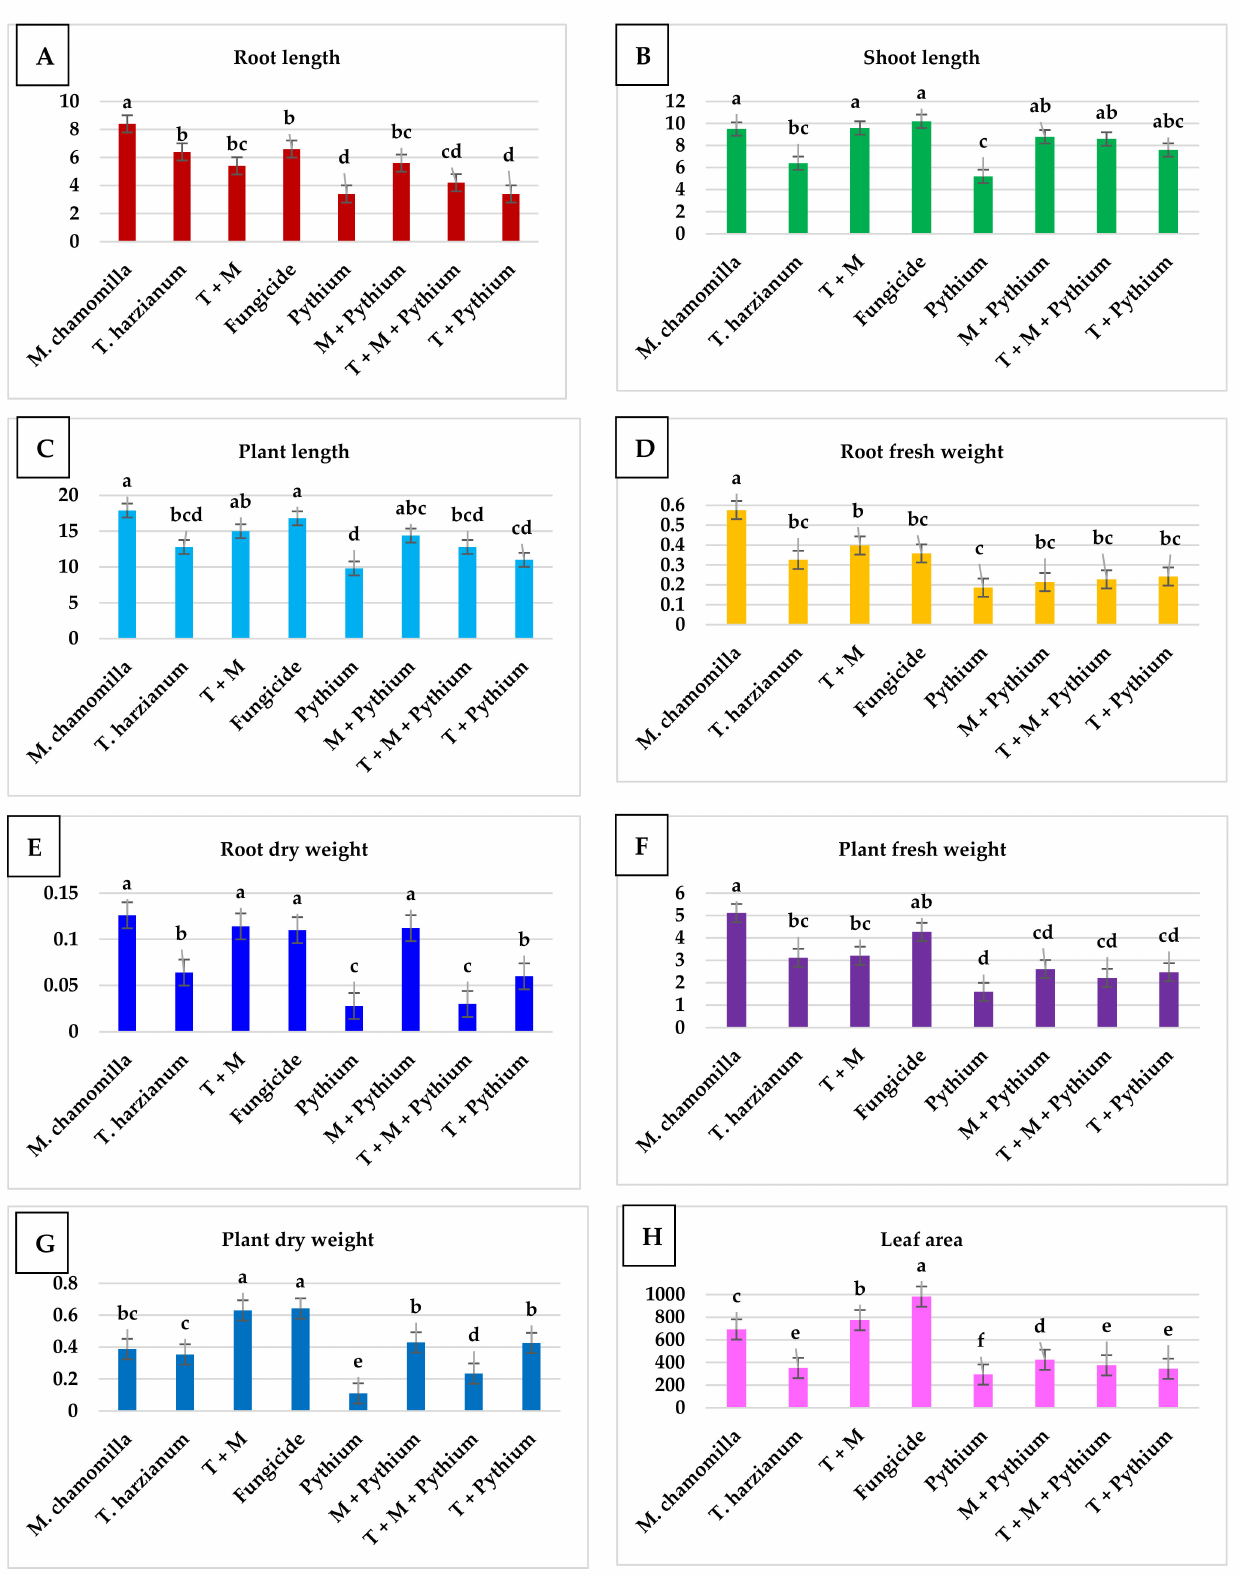
Figure 4. ( A ) root length, ( B ) shoot length, ( C ) plant length ( D ) root fresh weight, ( E ) root dry weight, ( F ) plant fresh weight and ( G ) plant dry weight, as well as, ( H ) leaf area of Phaseolus vulgaris as response to different